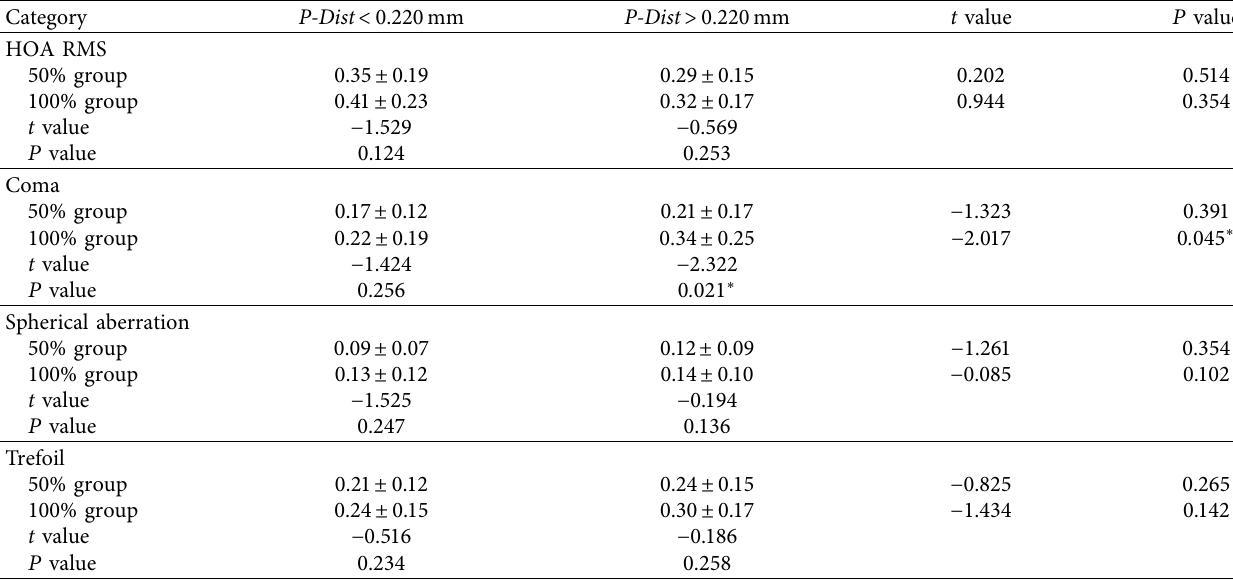
Table 3: Comparison of higher-order aberrations between different P-Dist groups at 3 months (the pupil diameter is